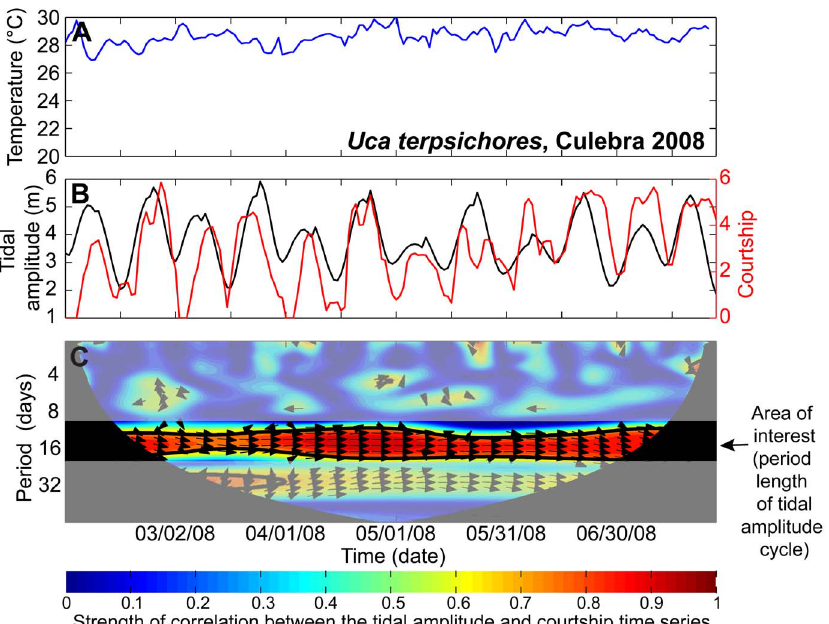
Figure 3. Wavelet coherence of courtship intensity and tidal amplitude. Time series of temperature (A), courtship intensity (square root of average number of males courting during the three scan samples, red line) and tidal amplitude (shifted one cycle earlier in time, black line) (B), and the wavelet coherence plot (C) for Uca terpsichores at Culebra for February to August 2008. In C, warmer colors represent stronger correlations between the courtship and tidal amplitude time series with dark blue indicating no correlation (0) and dark red indicating perfect correlation (1). When the correlation reaches a threshold level (0.5), arrows represent the phase relationship between the time series: right = in phase, left = anti- phase (180 degree offset between the time series), up or down = one time series is offset by 90 degrees from the other. The bold black line surrounding dark red areas indicates significant correlations between the two time series at the 5% level against red (AR1) noise. Data near the beginning and end of the time series can produce unreliable results and are thus covered by black on the plot (referred to as the ‘‘cone of influence’’ [47]). The time period of interest, one tidal amplitude cycle (12–17 days), is highlighted in bright colors. In subsequent figures, the wavelet coherence plots exclude periods outside this area of